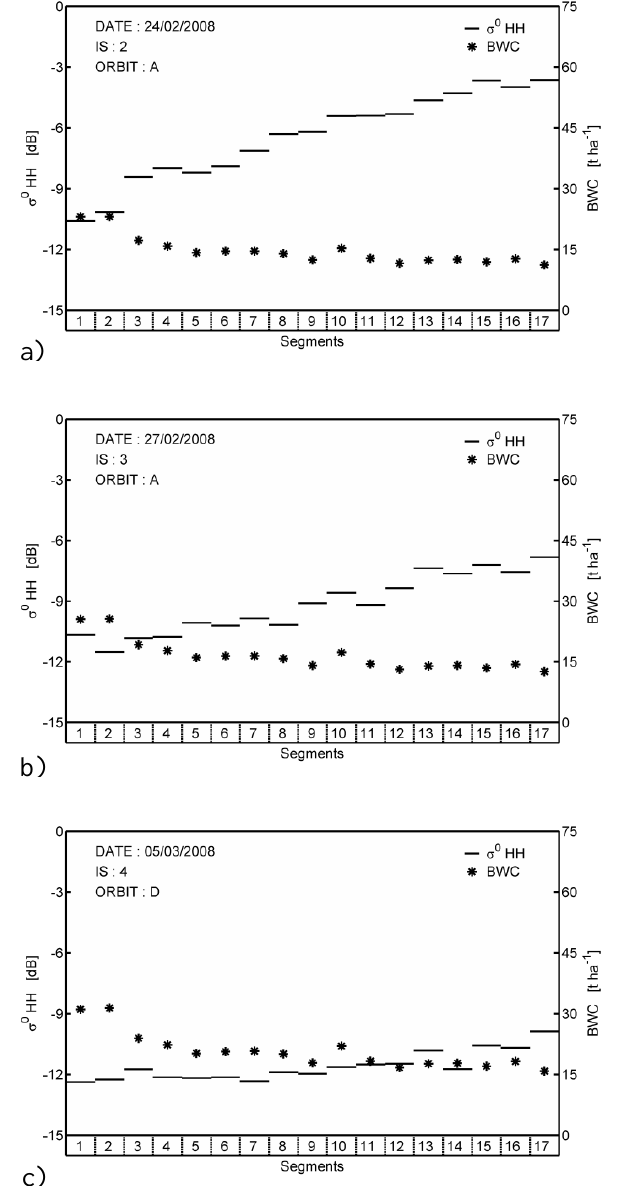
Fig. 6. Spatial behaviour of backscattering coefficient and biomass water content for three images acquired after the first irrigation time: (a) 24/02/2008, (b) 27/02/2008, (c) 05/03/2008. In order to extend this analysis to all the data set, we used two quantitative indices that describe σ 0 HH variations along the various segments of the largest field: amplitude and